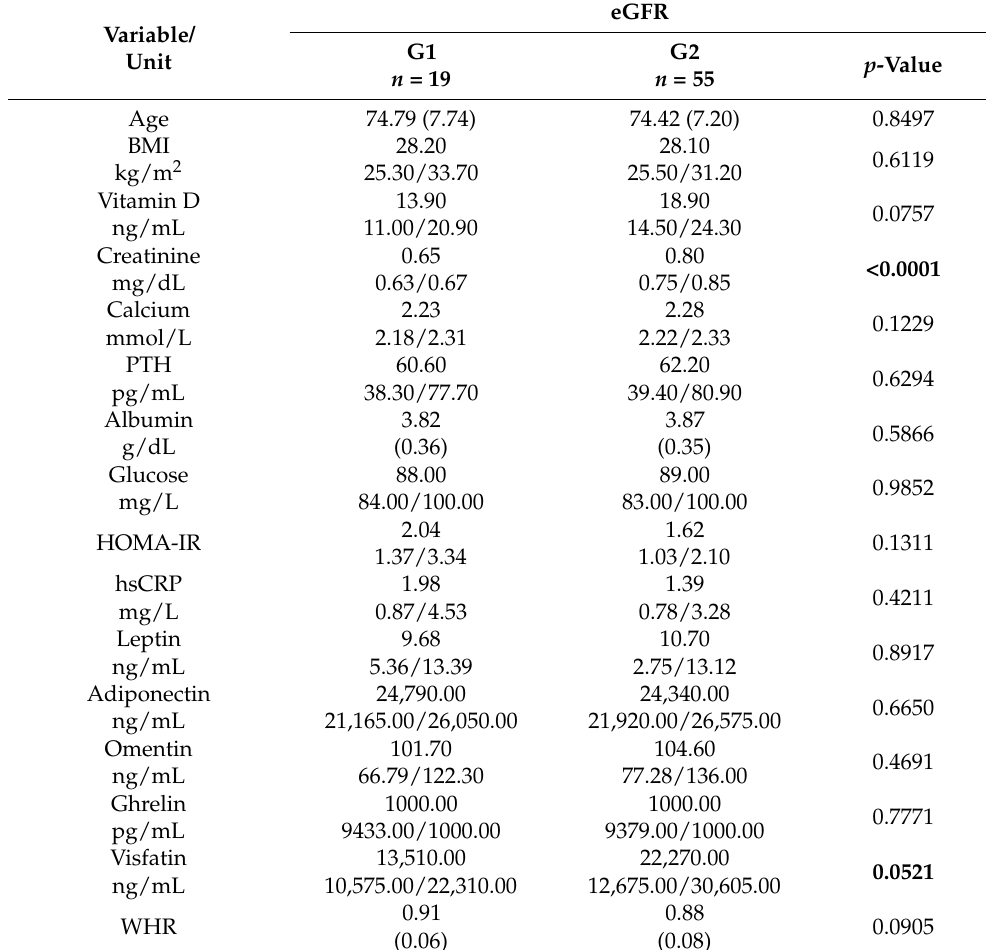
Table 3. Patients’ clinical characteristics according to KDIGO